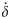
Cross-correlation of steer rate (δ˙) to bicycle roll rate (φ˙) versus speed.The cross-correlation decreases significantly with increasing speed (F = 34.307, p < 0.001) and decreases significantly more with increasing speed for cyclists than non-cyclists (F = 4.650, p = 0.035). All subject data are shown; connected points indicate data from the same subject.